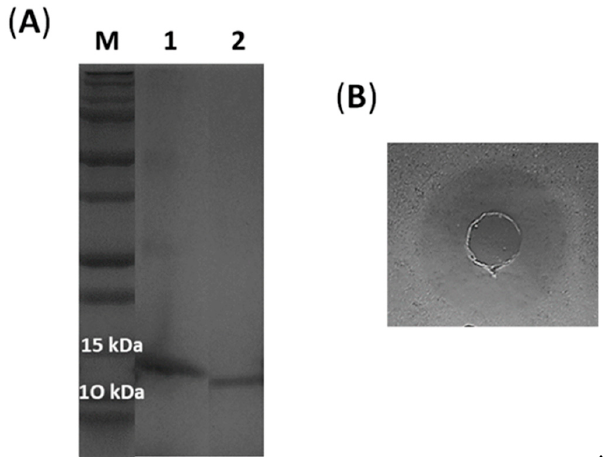
Figure 2. ( A ) Purified lacticaseicin 30 with (1) and without (2) histidine-tag (SDS-PAGE, 12% acrylamide), M correspond to size of proteins markers (Dual Xtra Standards, Bio-Rad). ( B ) Agar diffusion test against E. coli ATCC 8739 of lacticaseicin 30 (400 AU/mL) without histidine-tag.